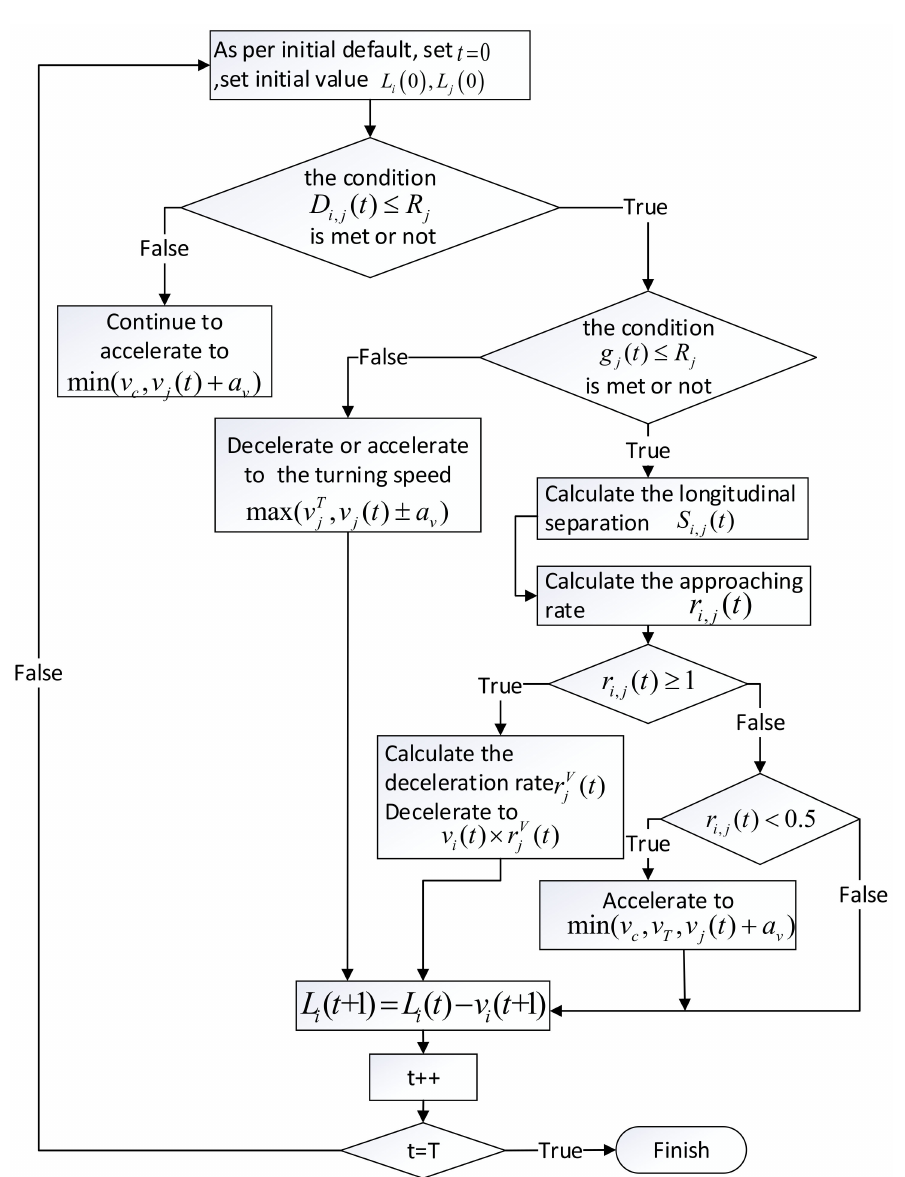
Figure 2. Flow Diagram of Model Simulation